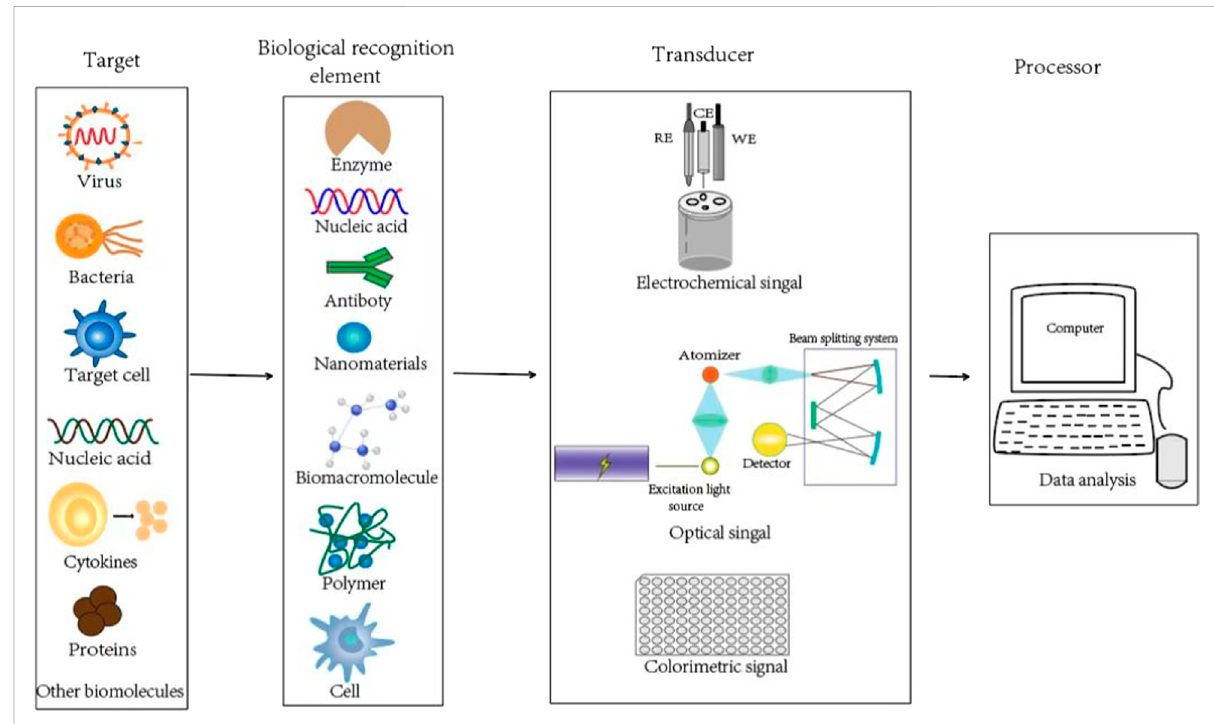
FIGURE 1 Schematics of the biological recognition element, transducer, and processor for typical nanobiosensors to detect the target bio-analytes.